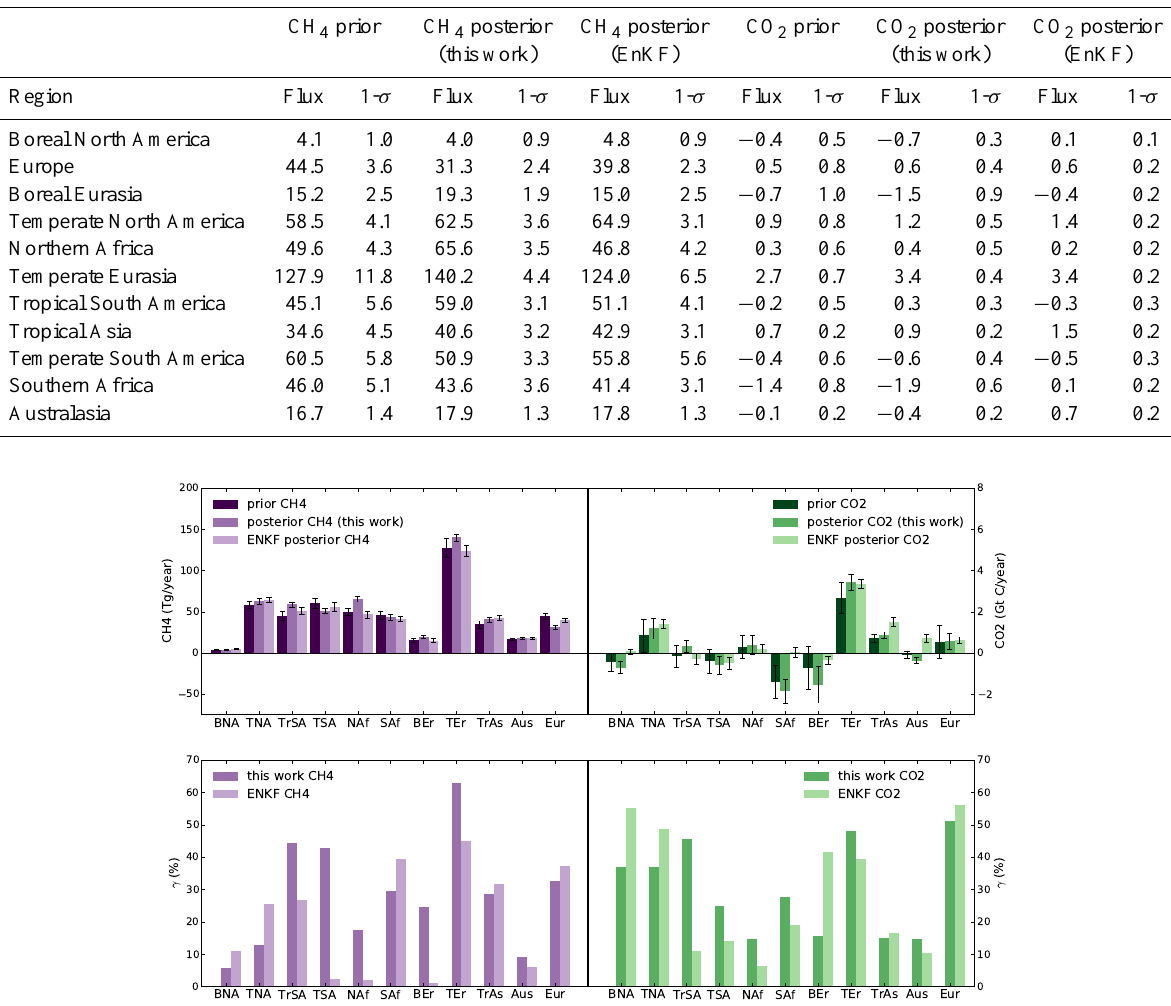
Figure 8. A priori and a posteriori CO 2 and CH 4 regional land fluxes (natural + anthropogenic) inferred from GOSAT XCH 4 : XCO 2 and surface measurements of CO 2 and CH 4 and from XCO 2 or XCH 4 using an EnKF (top) (Feng et al., 2011; Fraser et al., 2013), and the corresponding reduction in uncertainty (bottom), during 2010. Error bars atop emission estimates represent the 1- σ uncertainty.